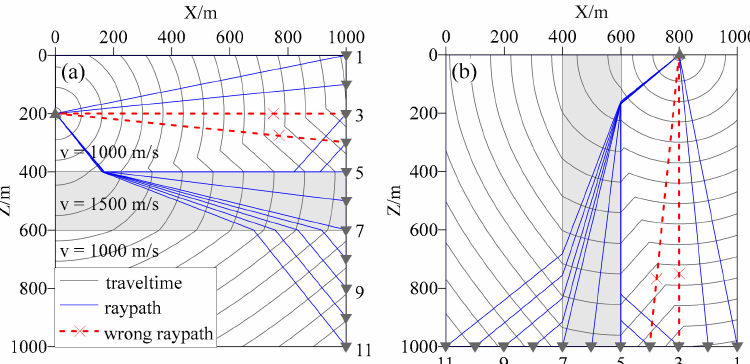
Figure 7. FMM ray tracing results of ( a ) transverse high-speed sandwich model and ( b ) vertical high-speed sandwich model. The gray triangle (cid:78) represents the source, the gray inverted triangle (cid:72) represents the receiving points, the gray shade represents the high-speed layer and the red dotted line with × represents the wrong